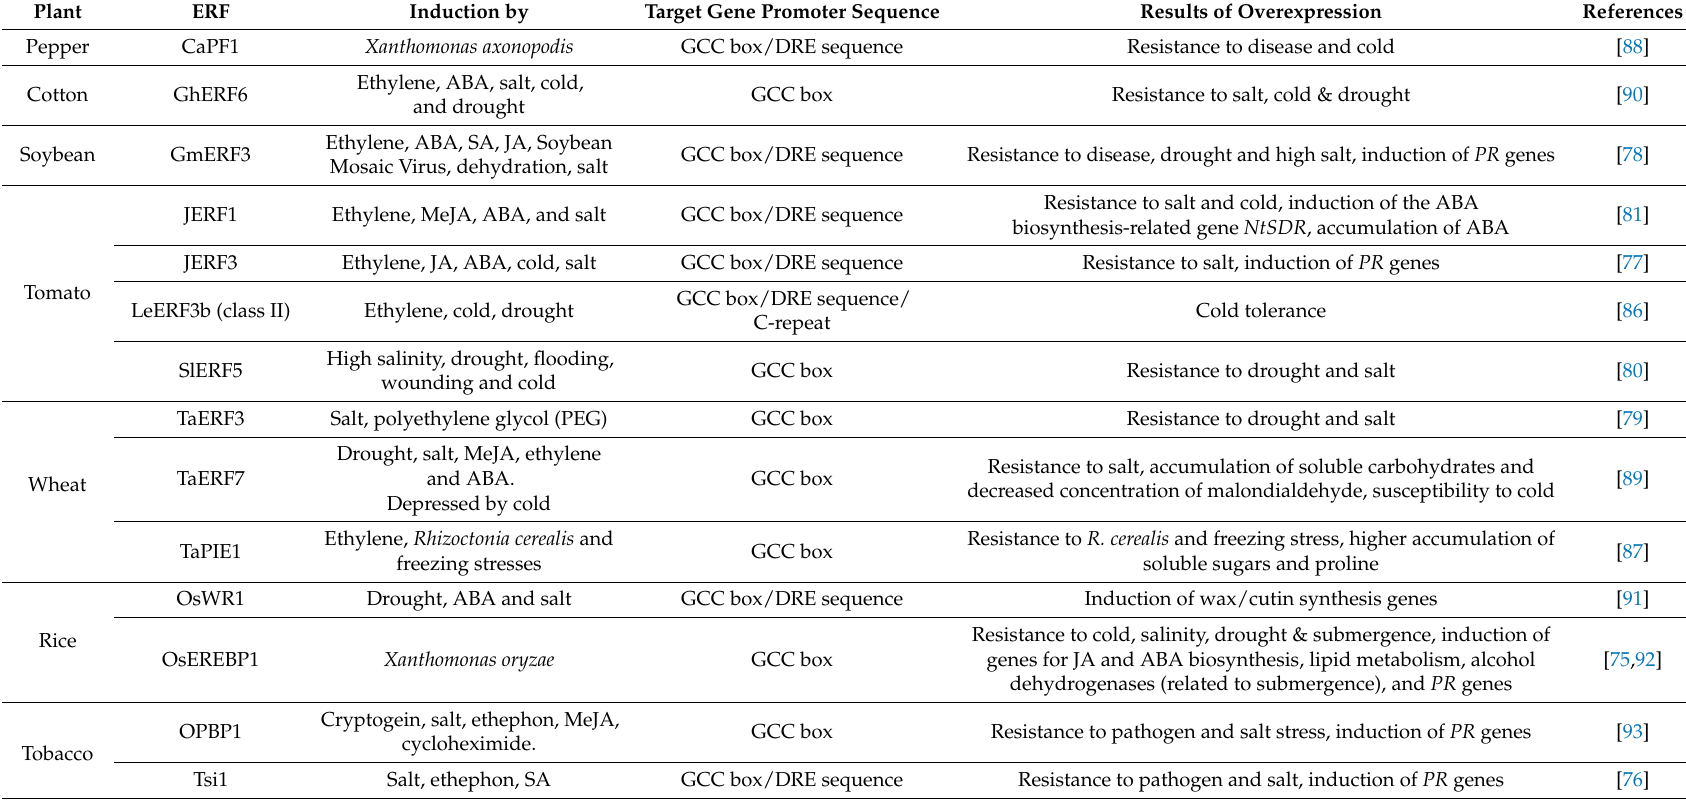
Table 2. Stress-responsive Ethylene Response Factors